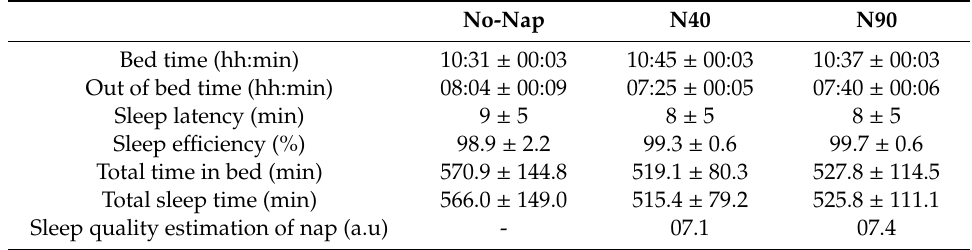
Table 1. Sleep parameters of the night preceding each condition (i.e., no-nap (N0), 40 min (N40), and 90 min (N90) nap opportunity), and the subjective sleep scale scores of each nap duration.